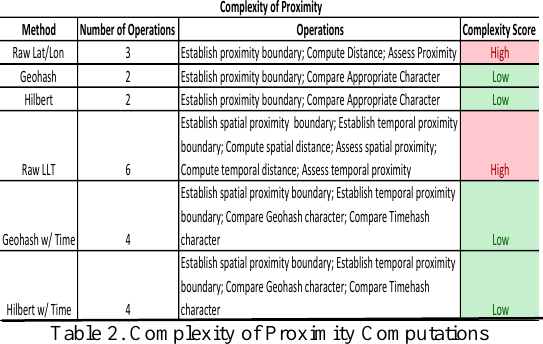
Table 2. Complexity of Proximity Computations